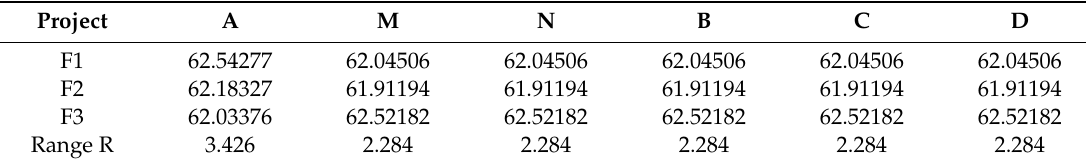
Table 12. The results of the range analysis.